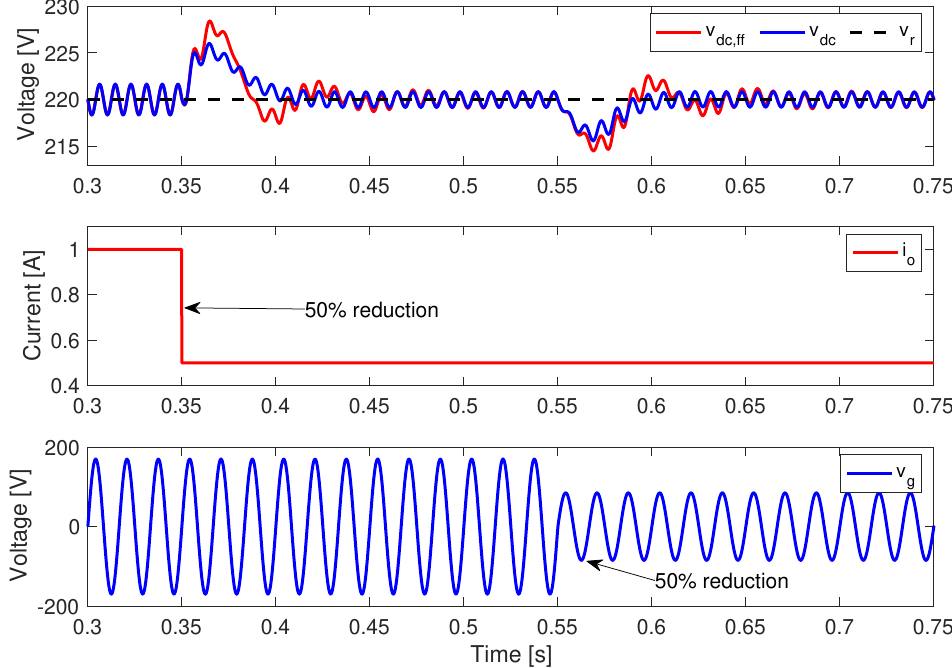
Figure 19. Performance comparison of the proposed solution with a feedforward/feedback